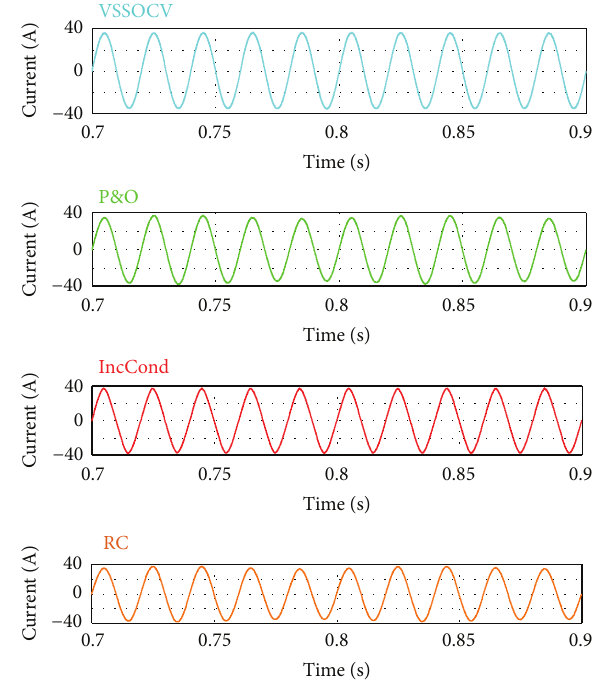
Figure 15: Injected current into the grid with different MPPT